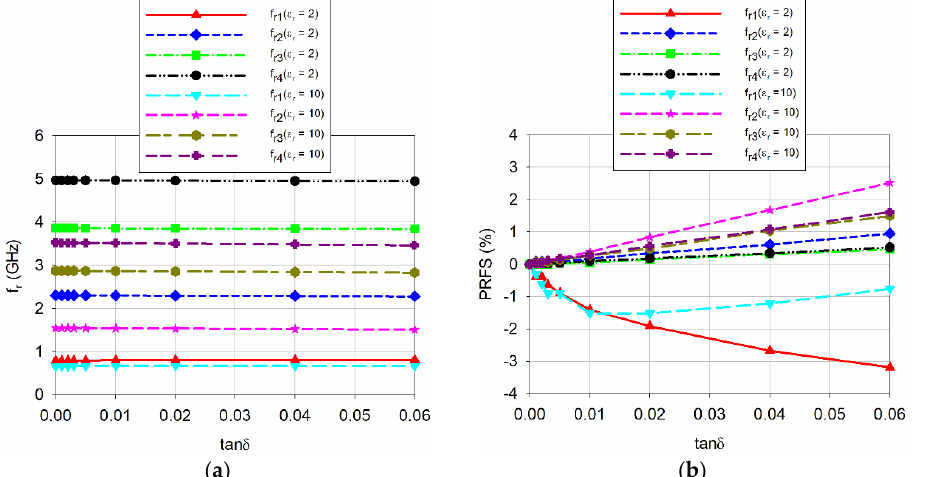
Figure 9. Variations on the first four resonant frequencies for the proposed scaled DR-CSRR DGS-loaded